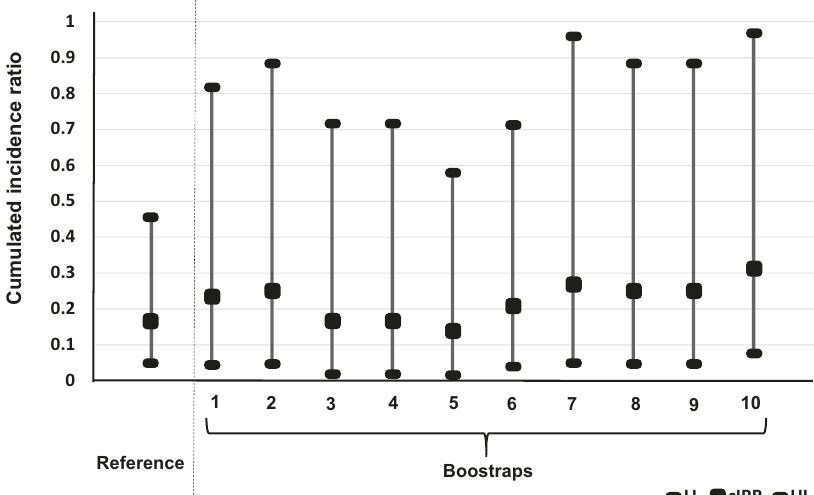
Fig. 4 Sensitivity analysis based on bootstraps estimating the cumulative incidence rate ratio of excretion of SARS-CoV-2 in saliva sample of fully vaccinated workers from nursing homes with COVID-19 mRNA BNT162b2 vaccine. cIRR, cumulative incidence rate ratio; LL and UL are the lower and the upper limits of the 95% con fi dence interval (exact binomial approximation).